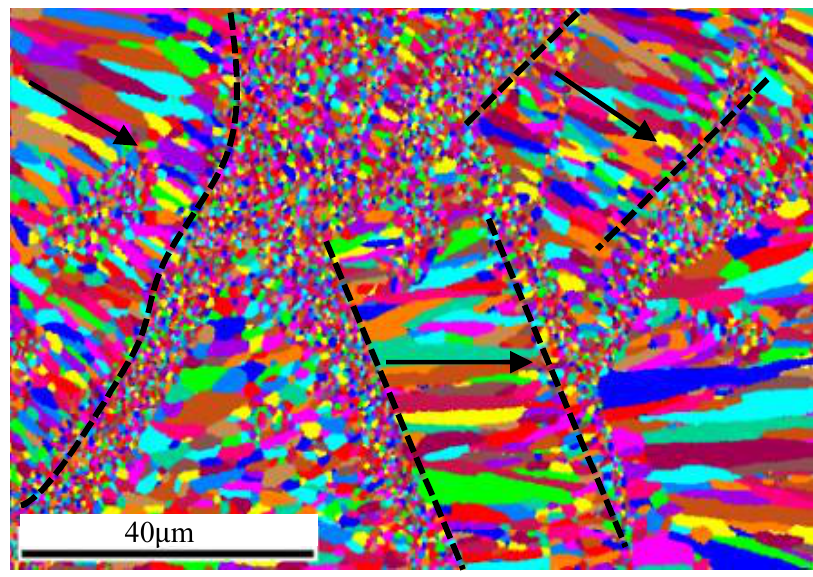
Figure 12. Microstructure variation in different paths.